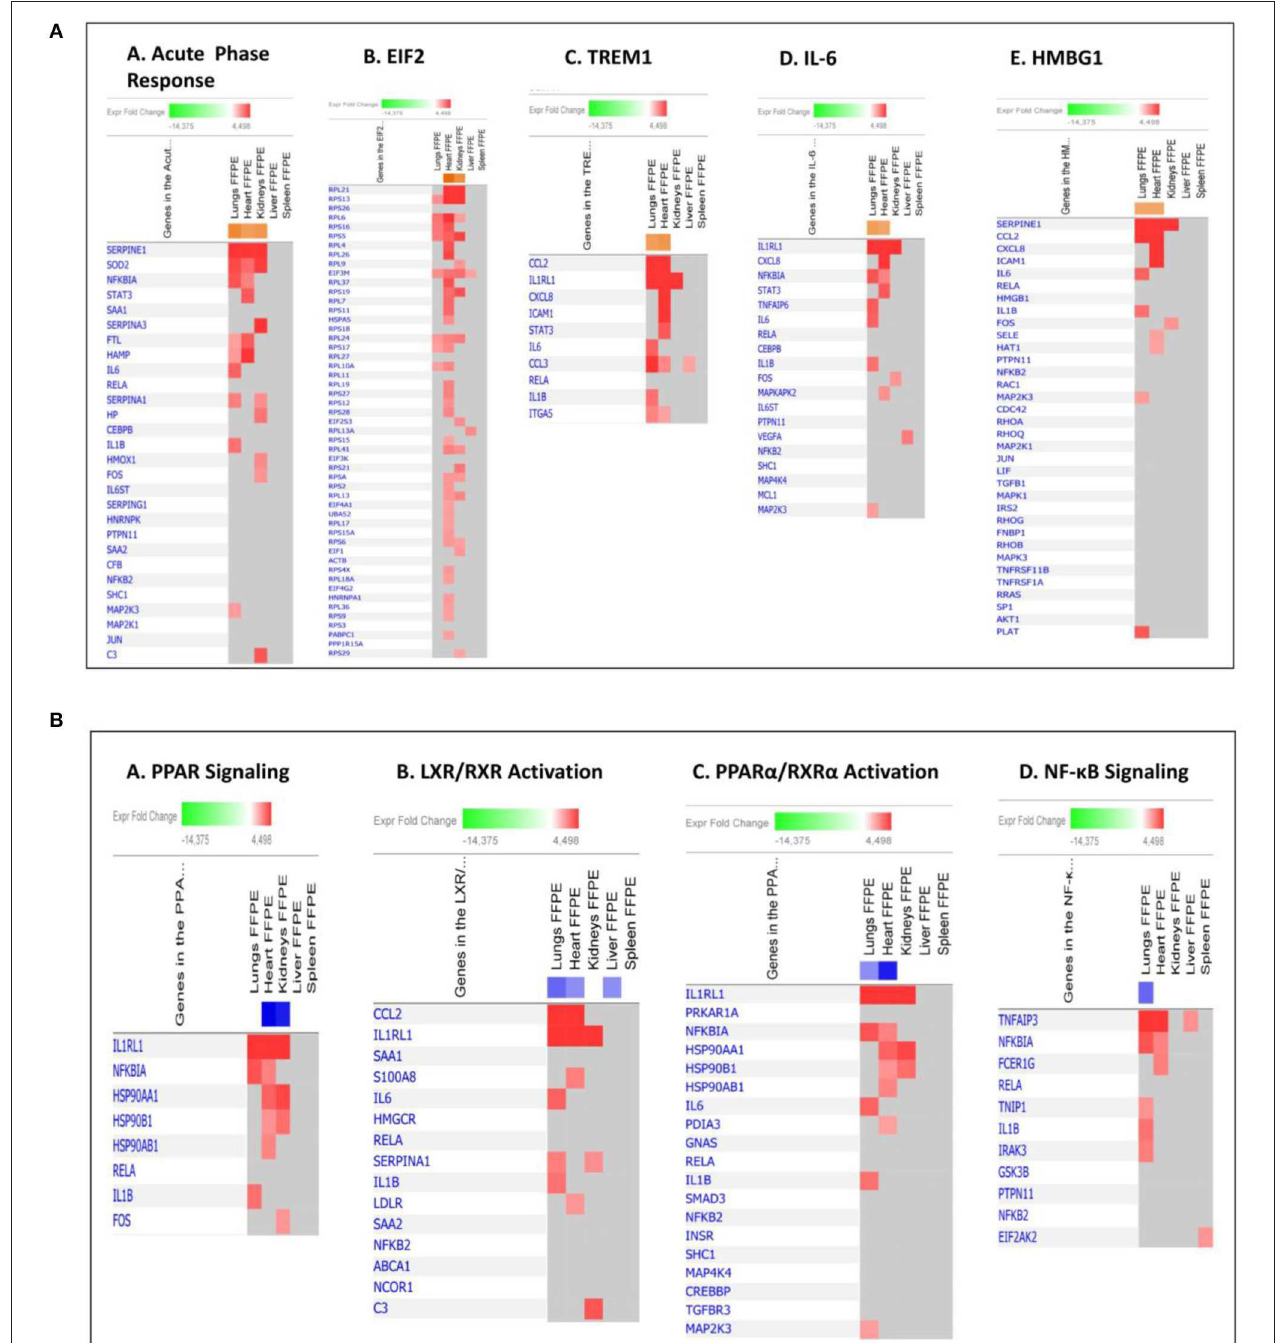
FIGURE 5 | Predicted gene signaling pathways from the top up-regulated (A) and down-regulated (B) canonical pathways in FFPE tissue samples from patients with meningococcal septic shock vs. controls. The Z-score indicates predicted activation state of canonical pathways. Orange or lighter shades of orange indicate a positive Z-score and up-regulation of the pathway. Blue color or lighter shades of blue indicate a negative Z-score and down-regulation of the pathway. The transcripts in the gene signaling pathway are expressed as Fold Change (FC) values. Red or lighter shades of red indicates positive FC-values and up-regulation of transcripts, green color or lighter shades of green indicates negative FC- values and down-regulation of transcripts. Color gray indicates that a predicted activation state of a gene/transcript in the canonical pathway signaling network is not affected.